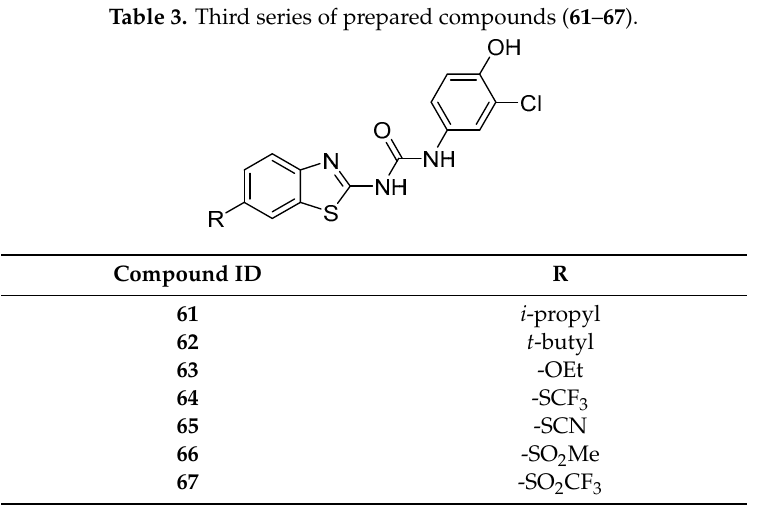
Table 3. Third series of prepared compounds ( 61 – 67 ).